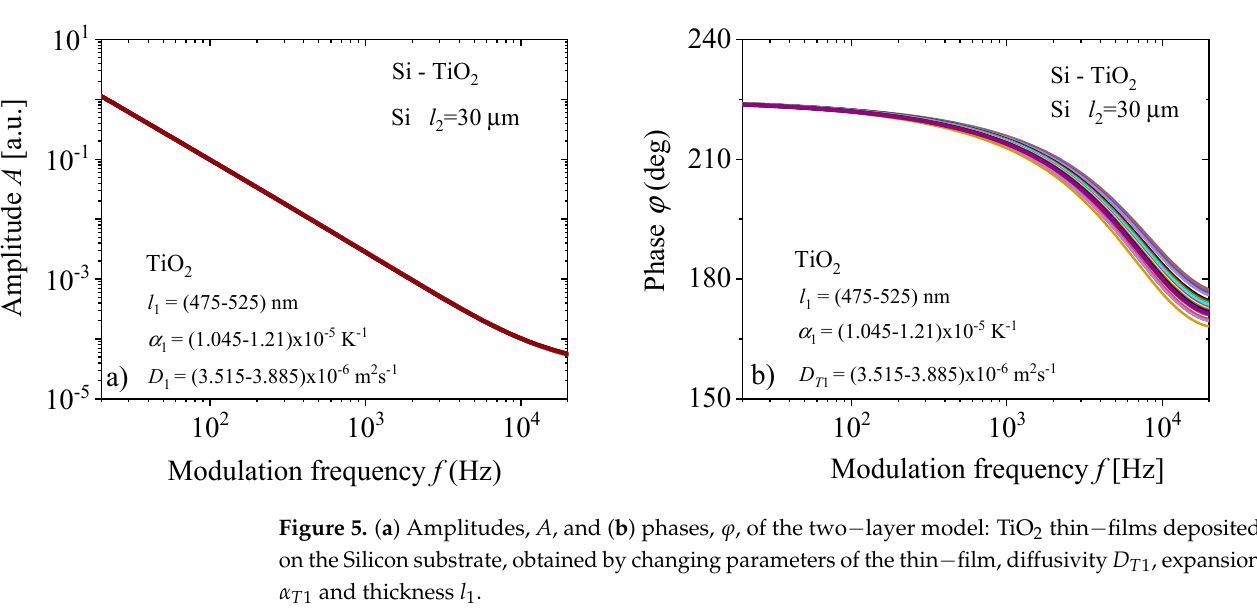
and to correctly determine the parameters of a thin layer that is two orders of magnitude thinner than the substrate.